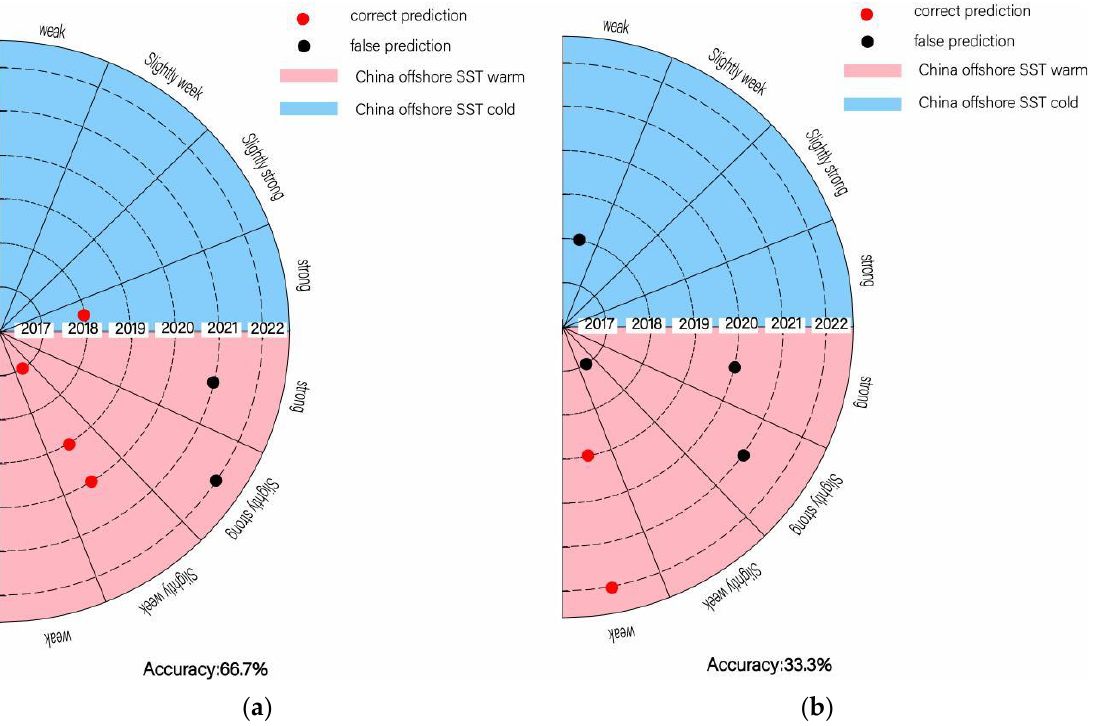
Figure 9. Forecast accuracy of southerly wind over Northeast China in ( a ) July and ( b ) August using the China offshore